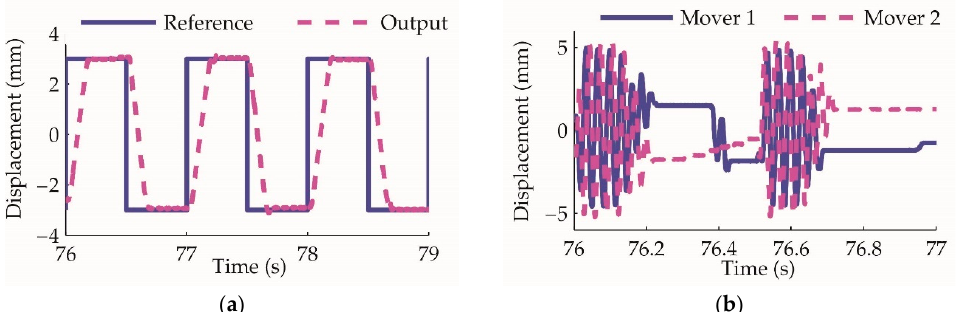
Figure 16. The actuator closed-loop control experiment: ( a ) the actuator cylinder position reference and output; ( b ) displacement of the two movers, the amplitude modulation and phase modulation is demonstrated.